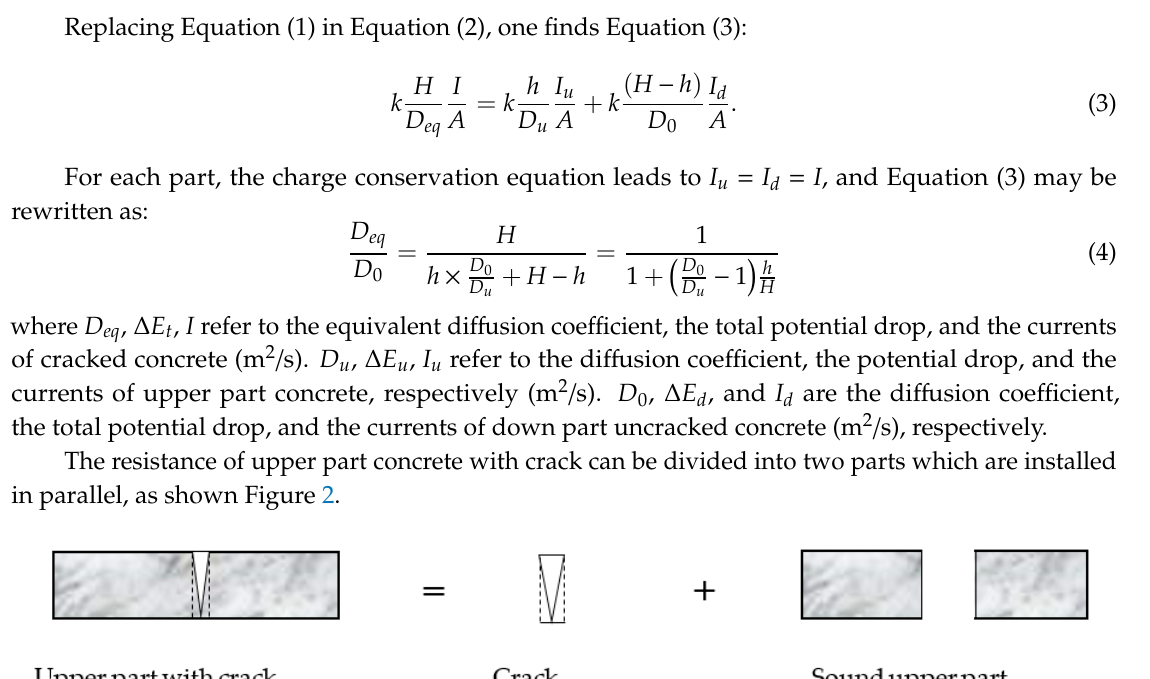
Figure 1. Partition hypothesis of resistance for cracked specimen.